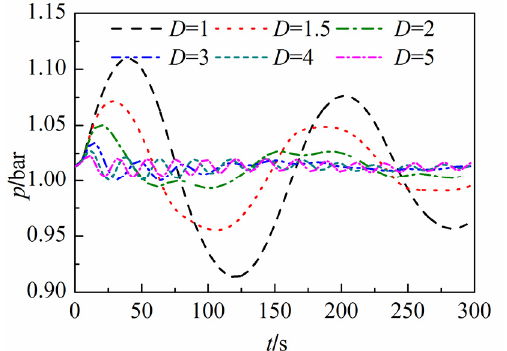
Figure 24. Effect of duct diameter on gas pressure.